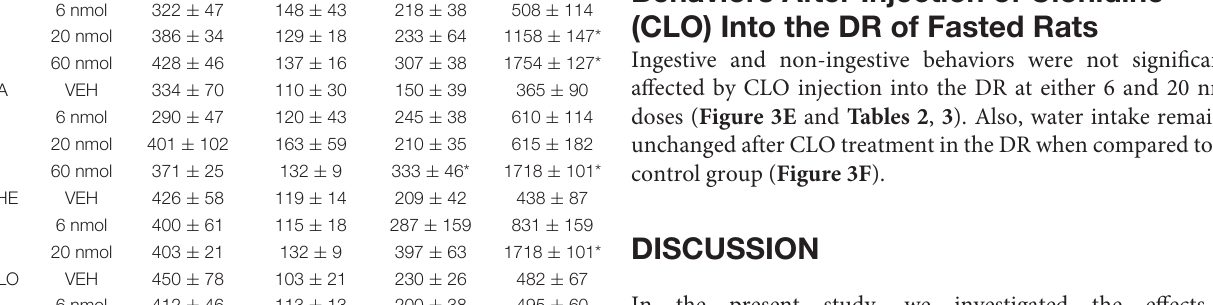
behaviors were increased after NA injection of 60 nmol dose ( Table 3 ). Other non-ingestive behaviors were not affected by NA treatment ( Table 3 ).